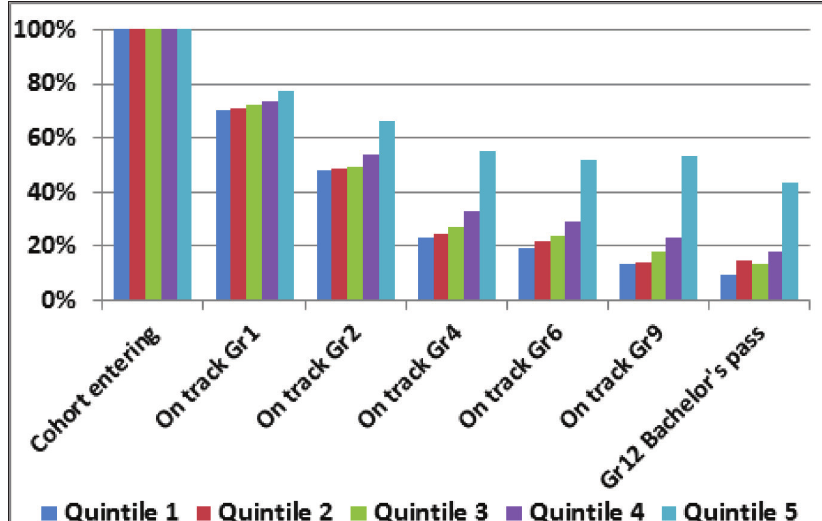
Figure 3: Proportion of entering cohort on track in various grades in ANA 2012, and Bachelor’s passes in Grade 12, by school quintile (Source: Own calculations from ANA